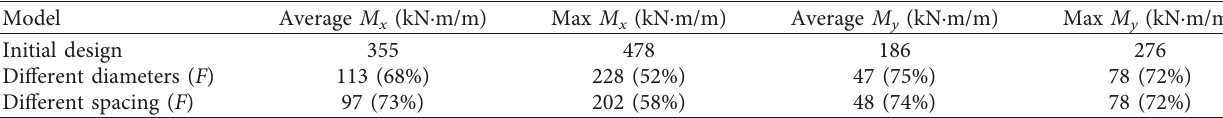
Figure 12: Integral bending moments of the raft along the (a) X axis and (b) Y axis. Table 11: Comparison of integral bending